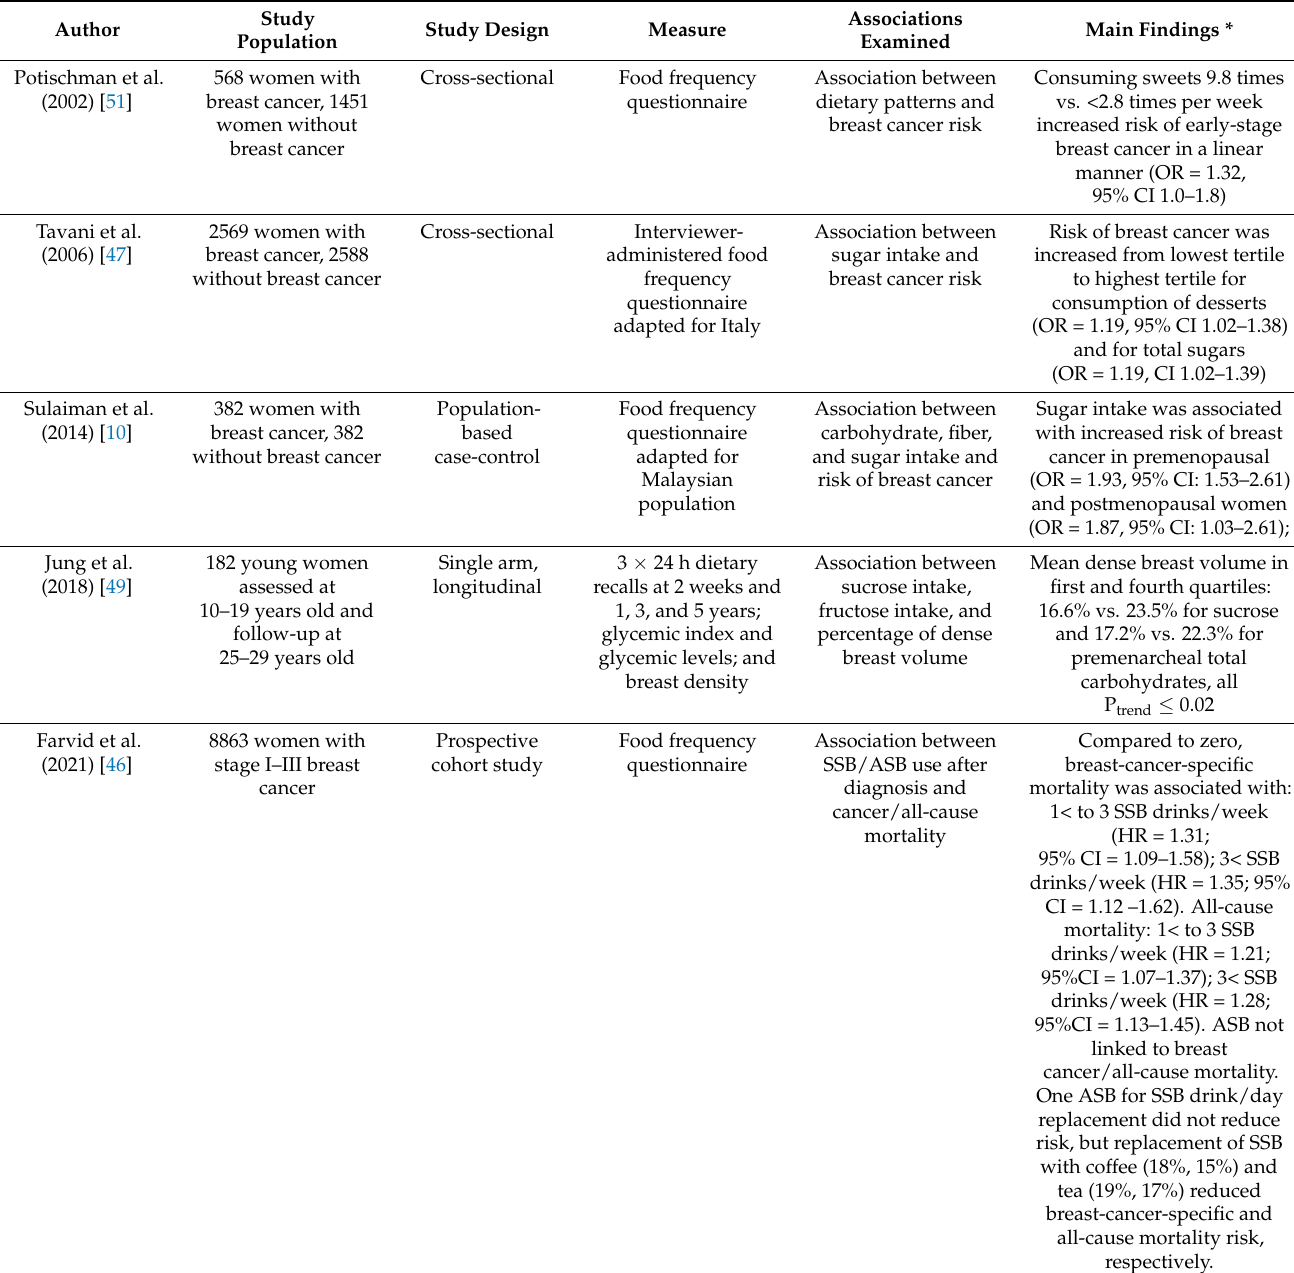
Table 1. Added sugar intake and risk of developing breast cancer and